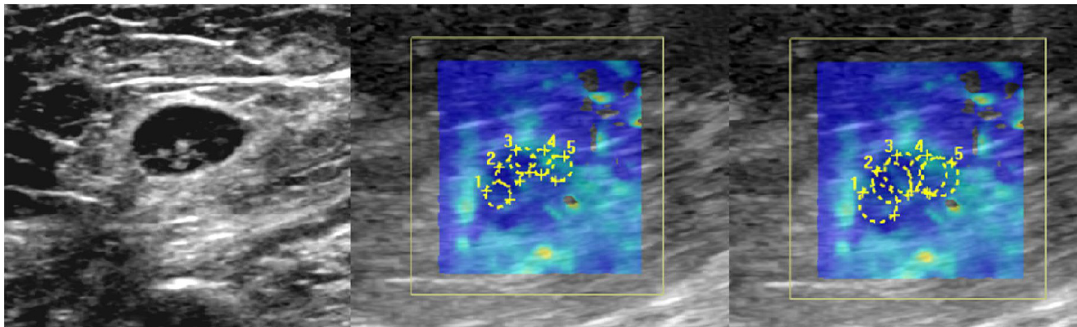
Fig 2. SWE measurements with different ROI sizes in axial plane. A 7 mm inguinal LN of a 70-year old woman with vulvar cancer is shown in B-mode image (left). The same LN is illustrated with five 2 mm (middle image) and 3 mm (right image) SWE ROIs. ROIs are centered evenly on the 4 mm cortex to cover majority of it. The Mean-E values were 7.8 kPa and 7.0 kPa with 2 mm and 3 mm ROIs accordingly. The LN proved to be histopathologically